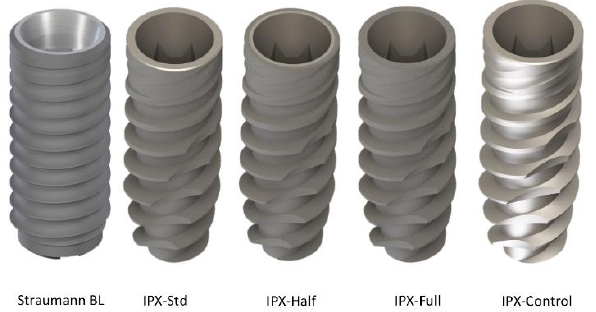
Figure 1. The topographic profiles and platform surfaces of the five implant designs evaluated: Straumann BL platform with SLA ® surface platform; IPX-Std with a fully machined platform; IPX-Half with Nanoblast Plus ® surface in the outer half of the platform and machined surface in the inner half of the platform; IPX-Full with the whole platform treated with Nanoblast Plus ® and IPX-Control with full body and platform machined.